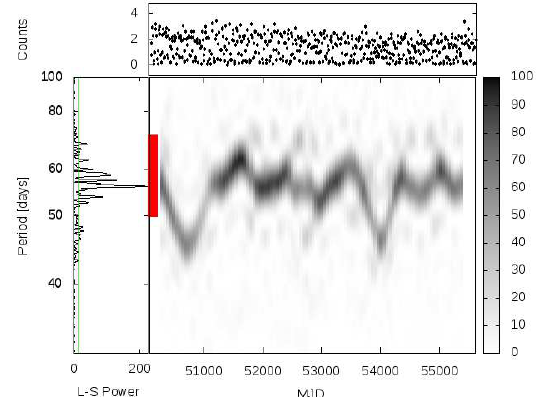
Figure 3: SMC X-1: The super-orbital period that is evolving dramatically over an even longer time-scale, may be associated with a radiation-driven warp that is variable.